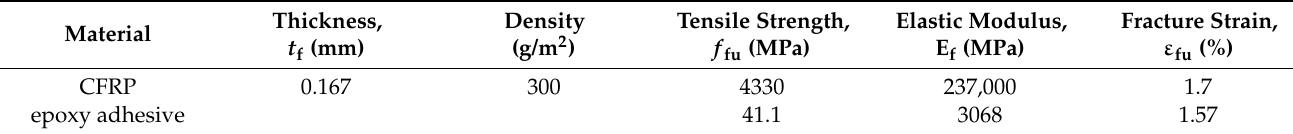
Table 2. Mechanical properties CFRP and epoxy